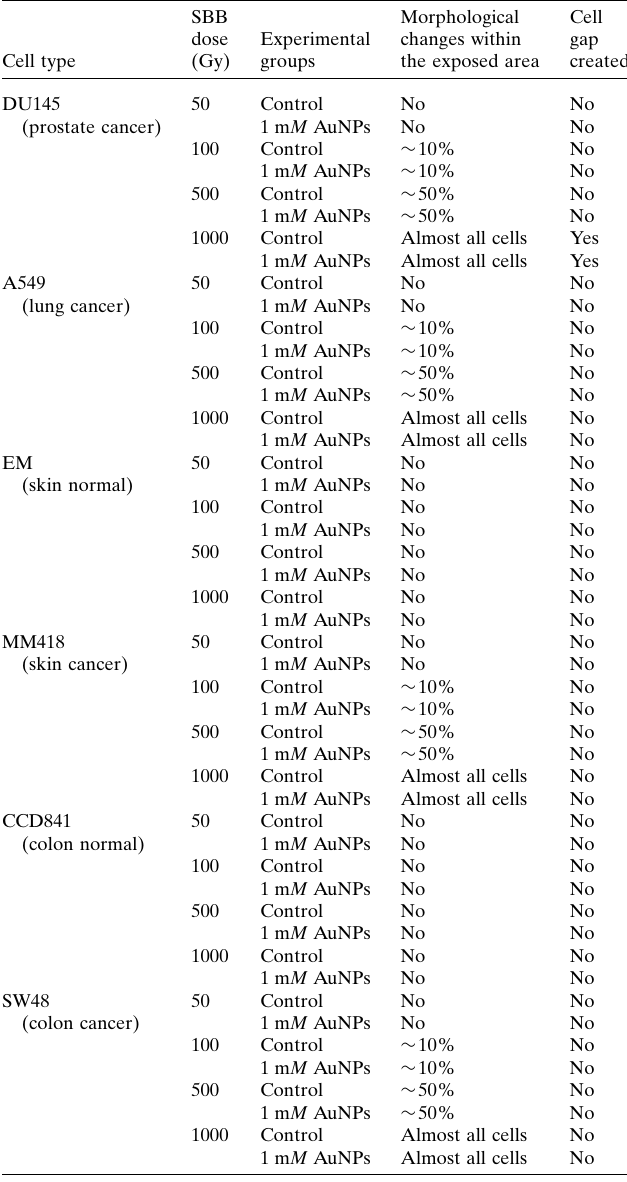
Table 1 A summary of the results of microscopic observation 24 h post-irradiation of DU145, A549, HEM, MM418, CCD841 and SW48 in control and treated groups irradiated with various doses of SBB.